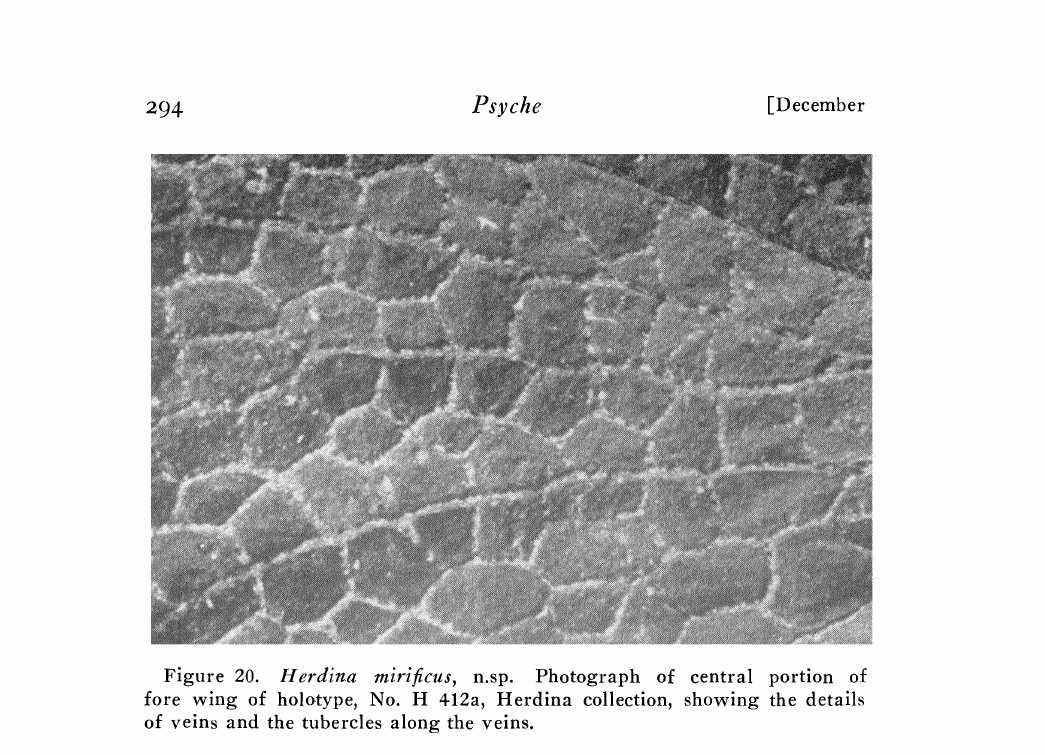
Figure 20. Herdina mirificus, n.sp. Photograph of central portion of fore wing of holotype, No. H 412a, Herdina collection, showing the details of veins and the tubercles along the